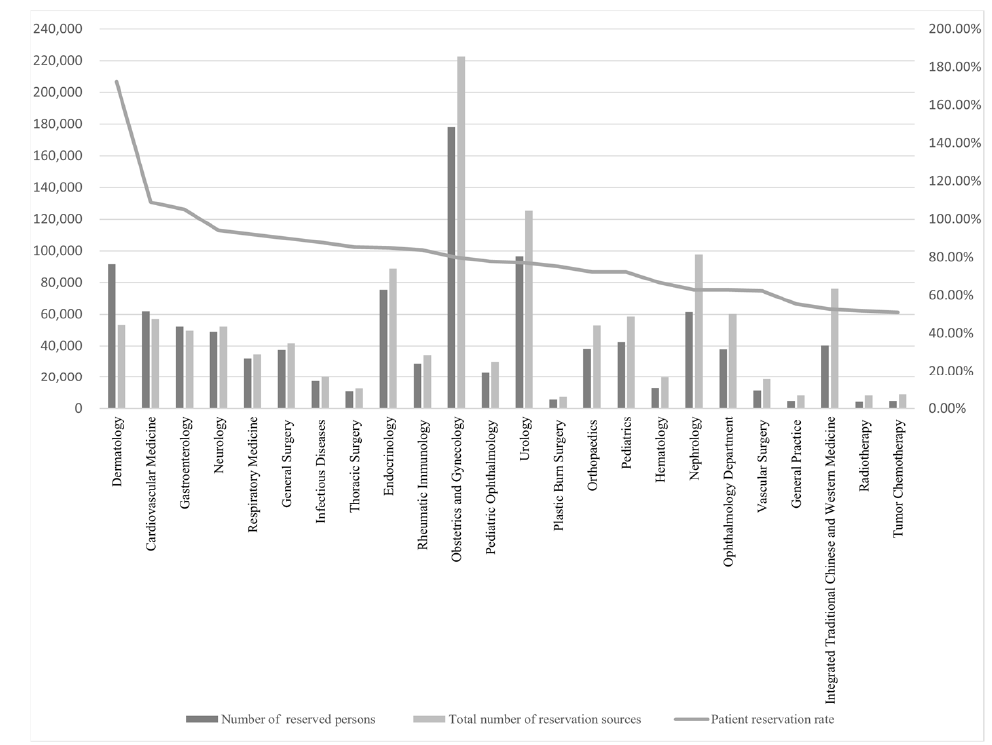
Figure 1. Patient reservation rates in each department.